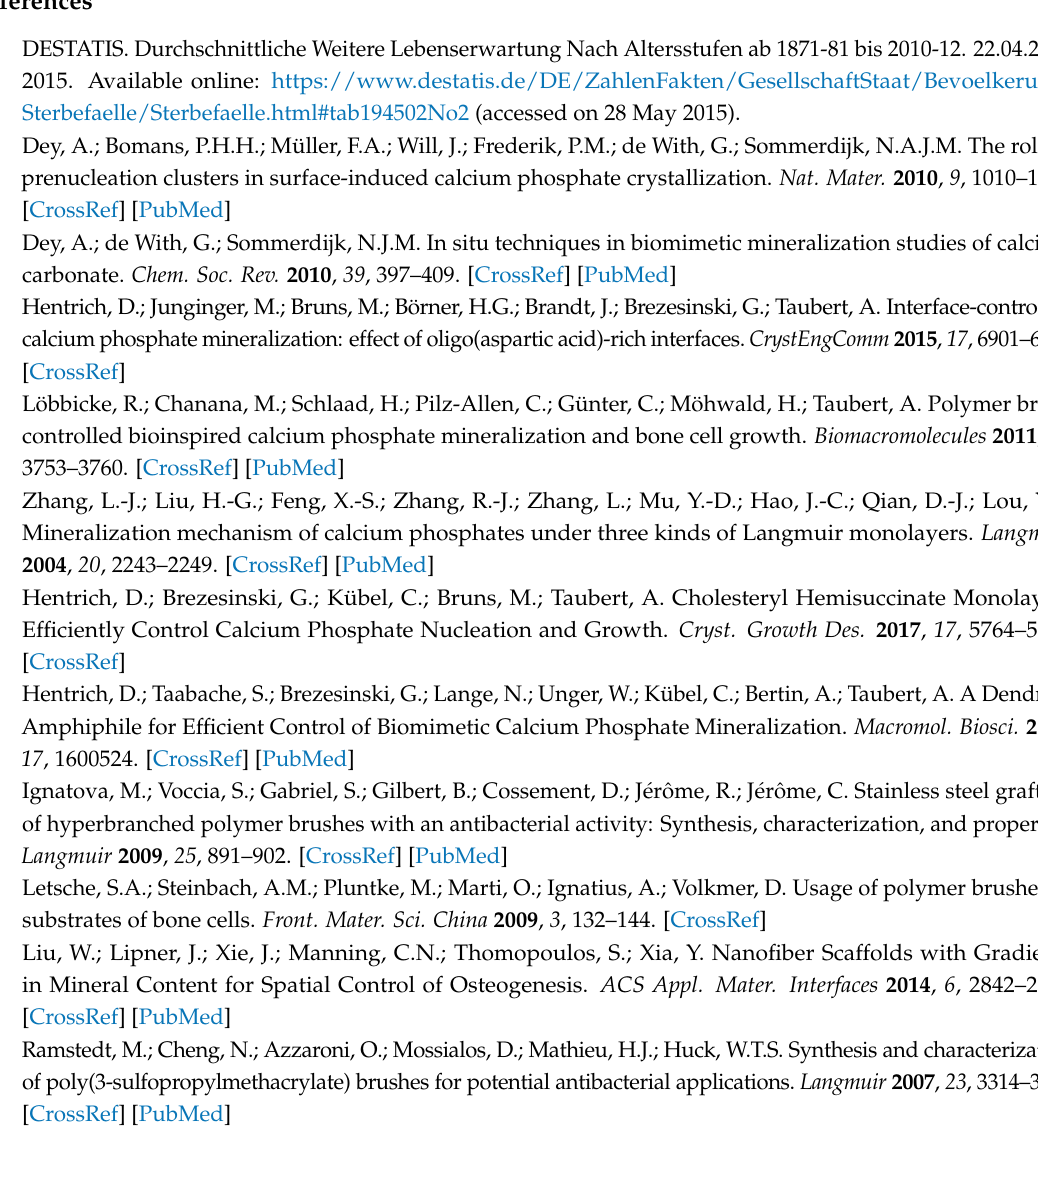
Table S1: Surface roughness analysis of the polymer brushes, Table S2: Chemical composition of the polymer brushes after mineralization. Figure S1: C 1s. O 1s. Ca 2p. S 2p. and P 2p XPS spectra of a Min1 surface, Figures S2–S7: Fluorescence micrographs of Dictyostelium discoideum amoeba on a Brush1, Brush2, Brush3, Min1, Min2 and Min3 surface, respectively. Small images to the left show the individual RGB channels (rotated by 90 ◦ ) for the cell the image showing microtubules (red), actin (green) and nuclei